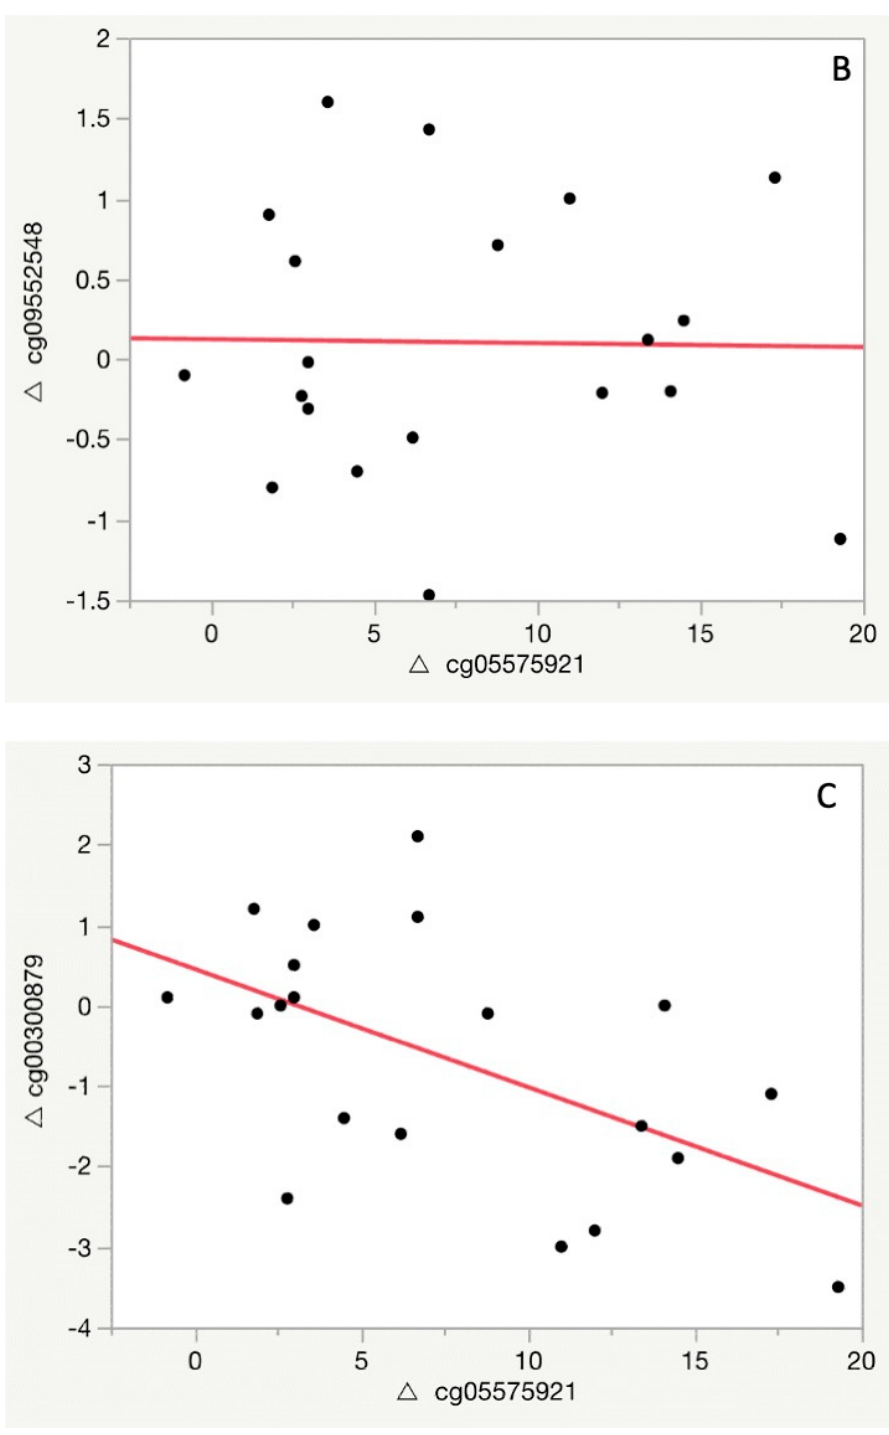
Figure 1. The relationship of change in increases in cg05575921 methylation seen in response to smoking cessation to changes in methylation at each of the three cardiac risk loci between study entry and study exit (3 months) in the 20 subjects who had biochemically verified smoking cessa- tion. ( A ) is a plot of the change of cg14789911 with respect to the change of cg05575921. ( B ) is a plot cg09552548 with respect to the change of cg05575921 methylation. ( C ) is a plot of the change of cg00300879 with respect to the change cg05575921 methylation. The change illustrated in ( C ) is significant after Bonferroni correction (Adj R 2 0.26, p < 0.04). A negative ∆ indicates an increase in methylation at the cardiac risk marker